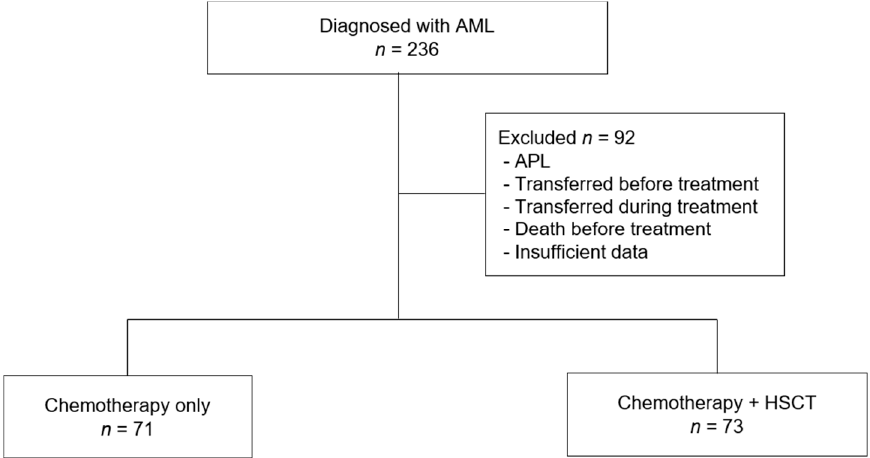
Figure 1. Flowchart of patient enrollment. AML, acute myeloid leukemia; APL, acute promyelocytic leukemia; HSCT, hematopoietic stem cell